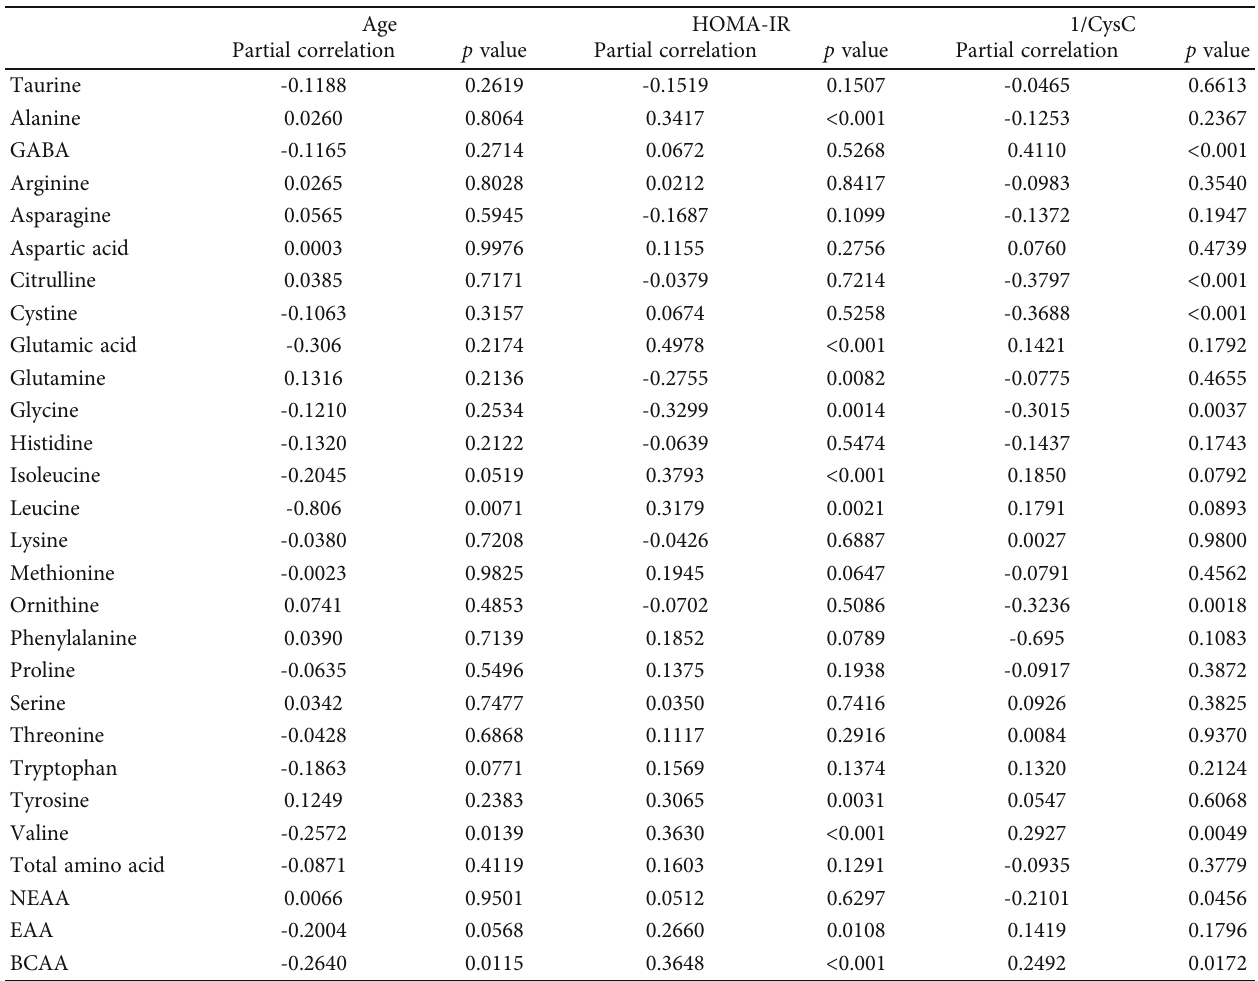
Table 4: Correlations between each amino acid according to age, HOMA-IR, and 1/CysC in patients with type 2 diabetes